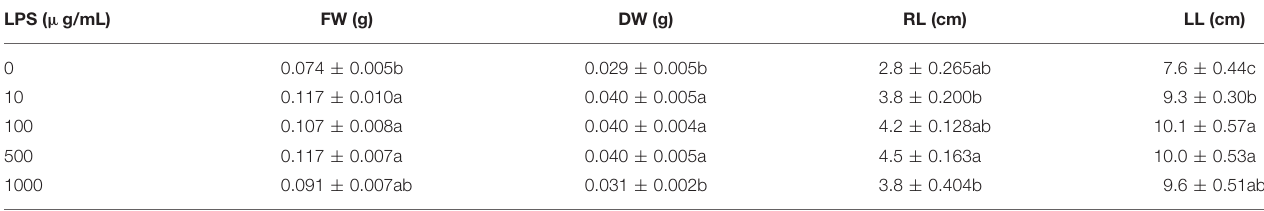
TABLE 1 | Effect of A. brasilense LPS on wheat seedling growth.